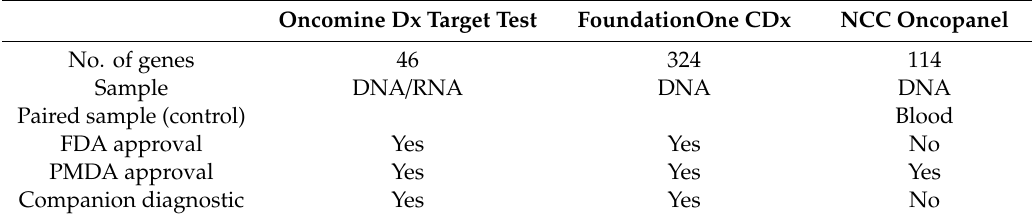
Table 1. Approved next-generation sequencing (NGS) panels in